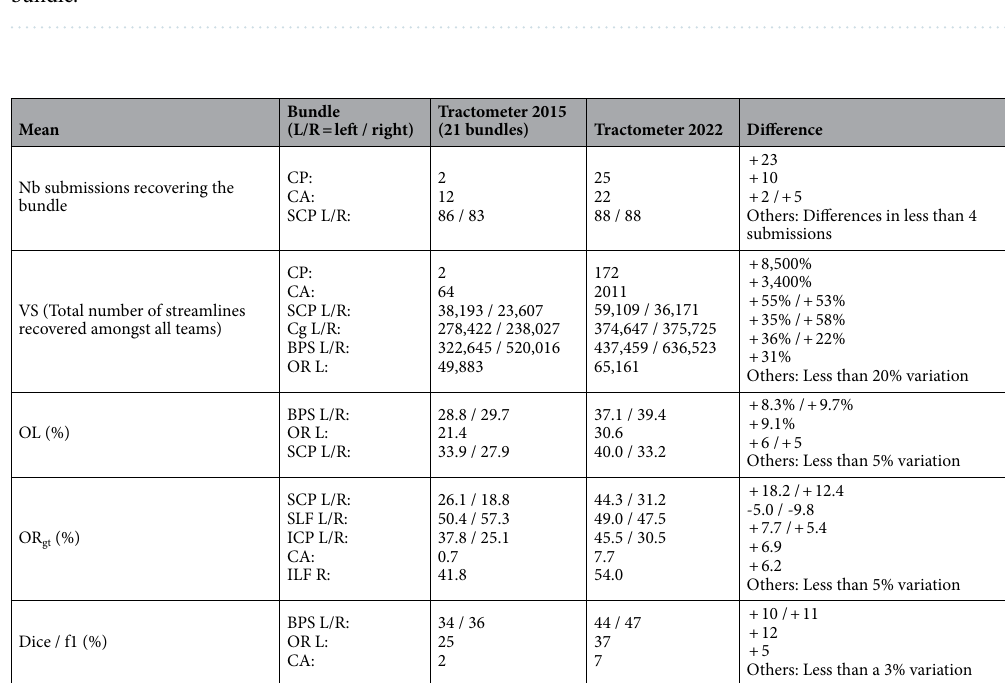
Table 3. Effect of the new scoring: some of the main changes in specific bundles (average over teams).